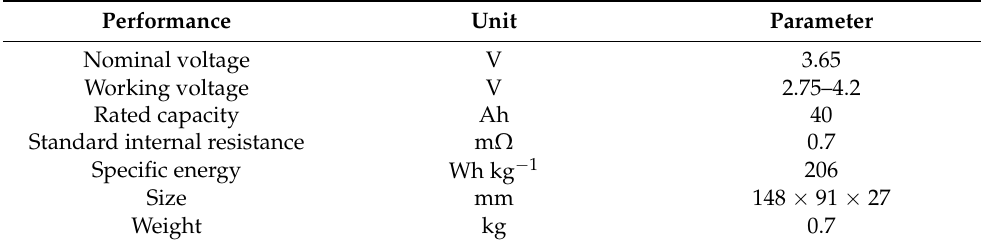
Table 2. Technical parameters of Li-ion